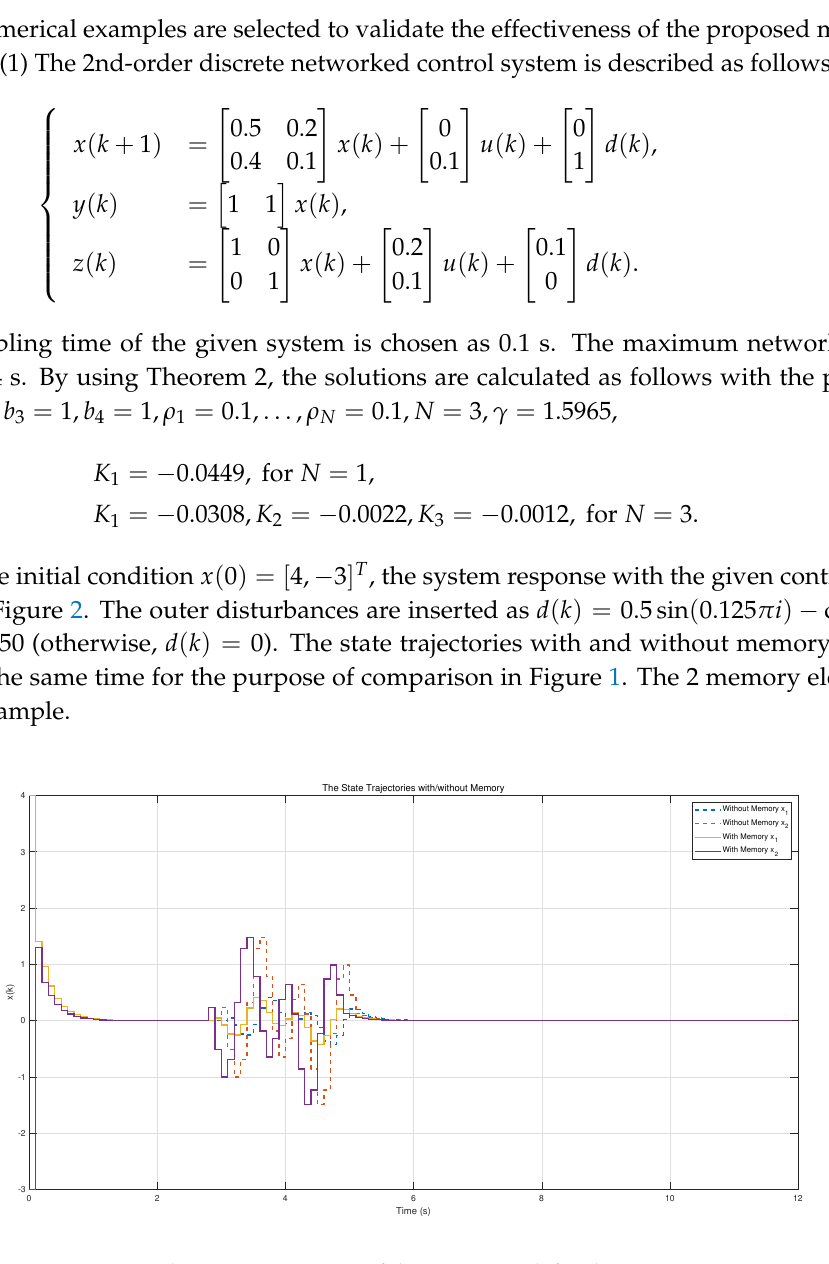
Figure 2. The state trajectories of the system with/without